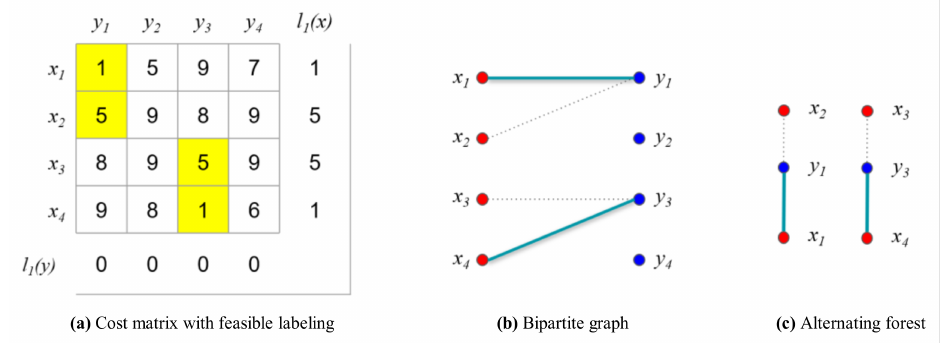
Figure 13. Example for the numerical experiment ( i = 1, j = 1).